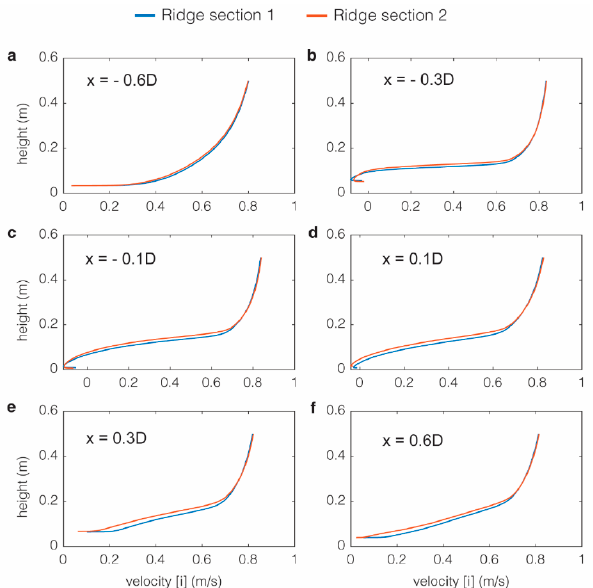
Figure 11. Position of line probes used to obtain vertical profiles across the ridge sections. Figure 12a shows a fully developed flow undisturbed by the nest geometry. Flow reversals in the lower regions corresponding to the recirculation zone can be observed in Figure 12b–d. The flow is reattached by the time it reaches the downstream ridge. A similar behaviour is observed in the valley sections (see Figure 13). Slight variations in velocity profile are observed for the ridge sections. No significant difference is observed for valley section results, apart from the absence of the weaker recirculation zone in the downstream valley depression.